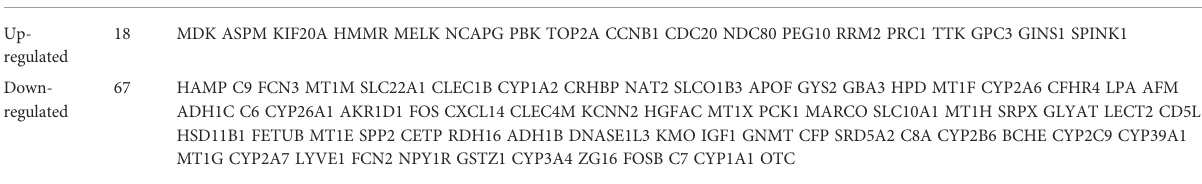
TABLE 2 85 Differentially expressed genes (DEGs) were identi fi ed from four GEO datasets. DEGs